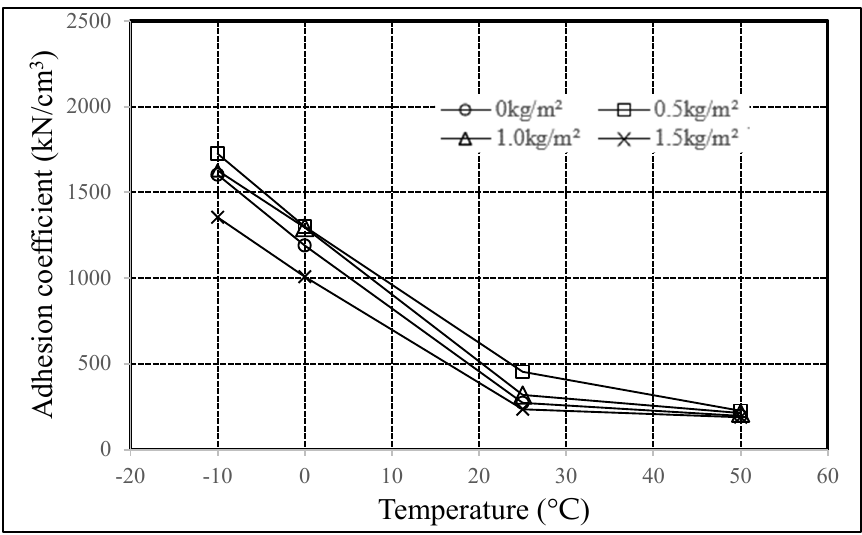
Figure 10. Influence of temperature on the bonding coefficient of oil B bond specimen.